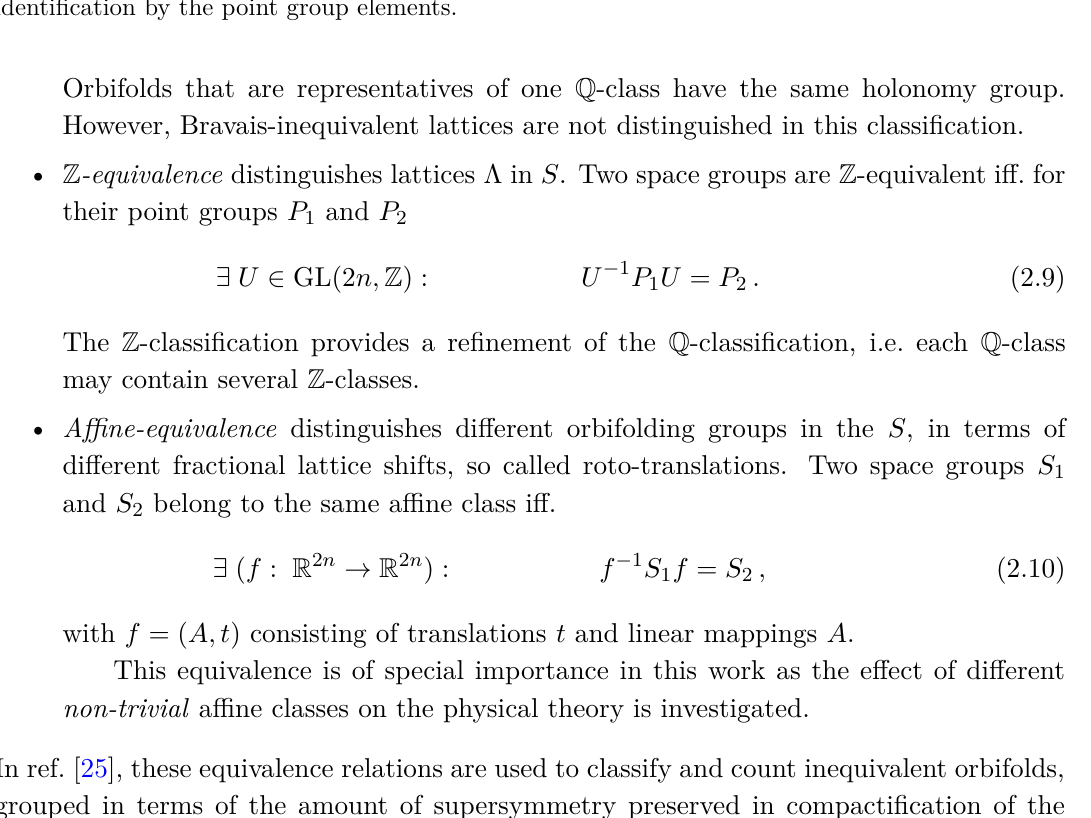
Figure 1 . Depiction of the action of a pure rotation generated by ϑ by 120 ◦ of a an orbifold fixed point (pink) in a torus T 2 = R 2 / Λ . After a lattice shift by e the point is transported 1 SU(3) back onto itself. Note, the light gray region is the fundamental domain of the lattice, opposed to the fundamental domain of the orbifold in darker gray, which is smaller due to the additional identification by the point group